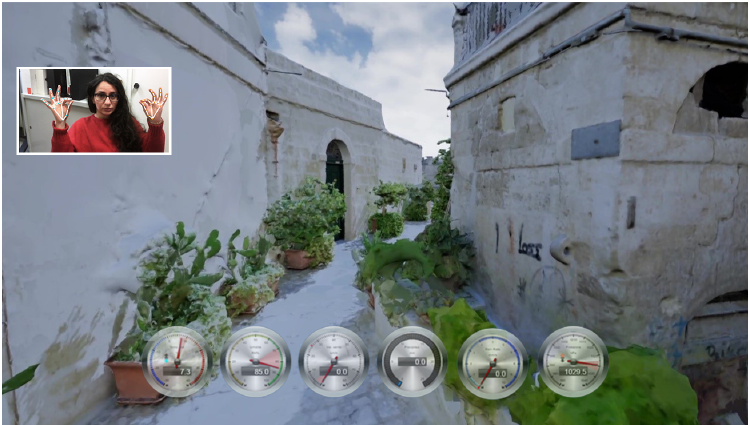
Figure 10. A view of the virtual walkthrough application, with a real-time virtual dashboard.